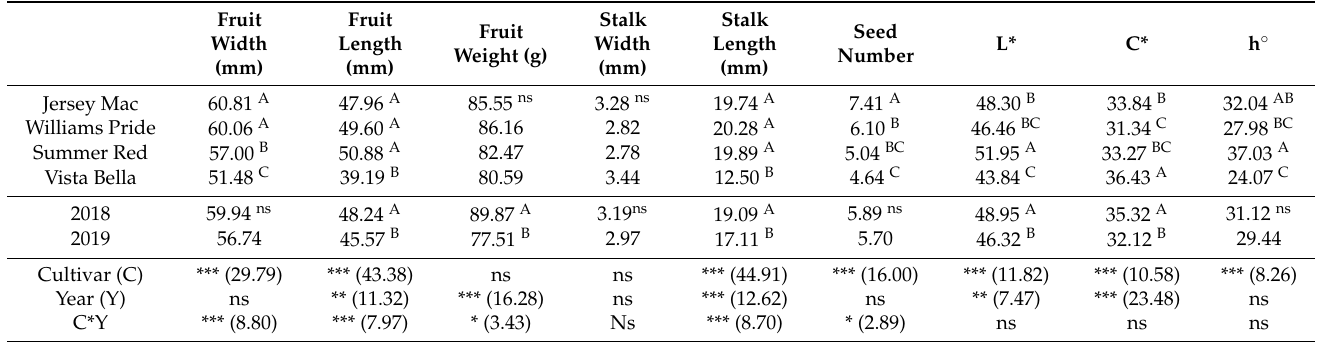
Table 2. Distribution of pomological characteristics by cultivars and